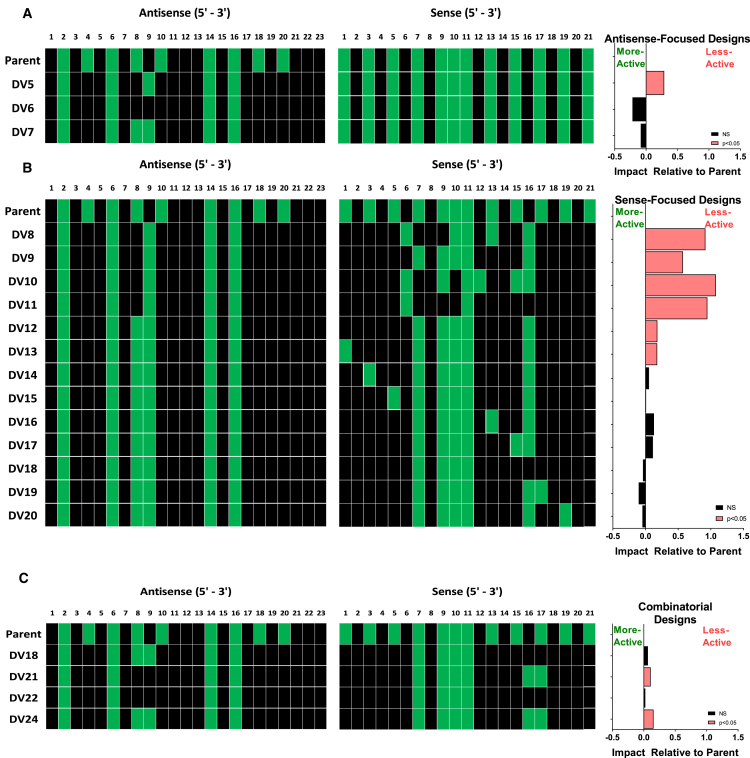
Sense and Antisense Strand Optimization(A and B) Antisense (A) and sense (B) strand designs utilizing four siRNAs targeting the mouse transthyretin (Ttr) gene (Table S1) and the combination of best designs (C) evaluated across all 10 siRNAs (Table S1). Impact relative to parent is depicted as the model-adjusted mean difference in activity of design variant (DV) compared to parent, and it is presented in natural log. 2′-F and 2′-OMe modifications are depicted as green and black squares, respectively.